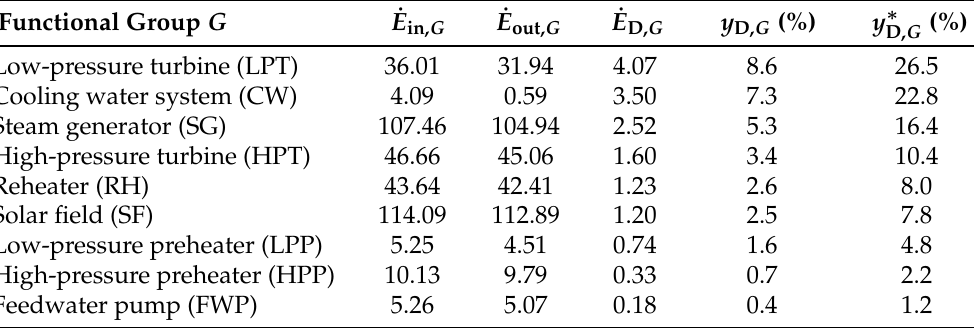
Table 4. SEGS—Results of the exergy analysis, functional groups. If not given, dimension of data is